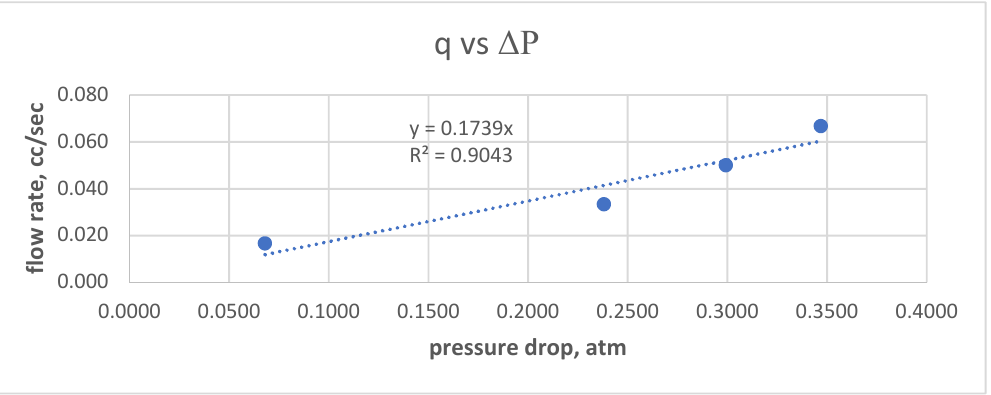
Figure A2. Average permeability calculation.